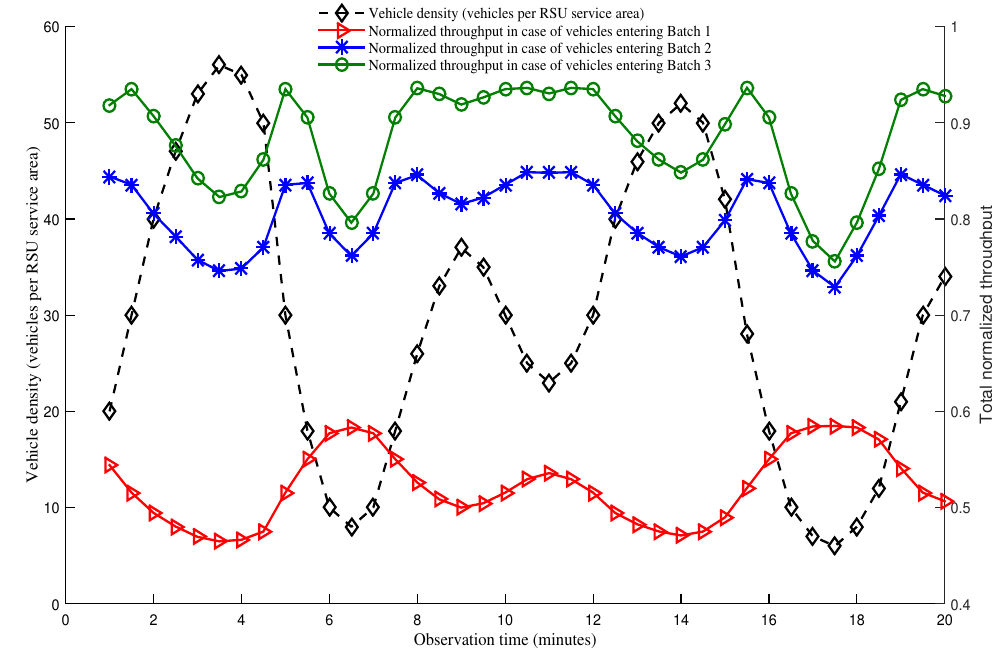
Figure 13. Relationship between vehicle density and total normalized throughput considering both saturated and non-saturated